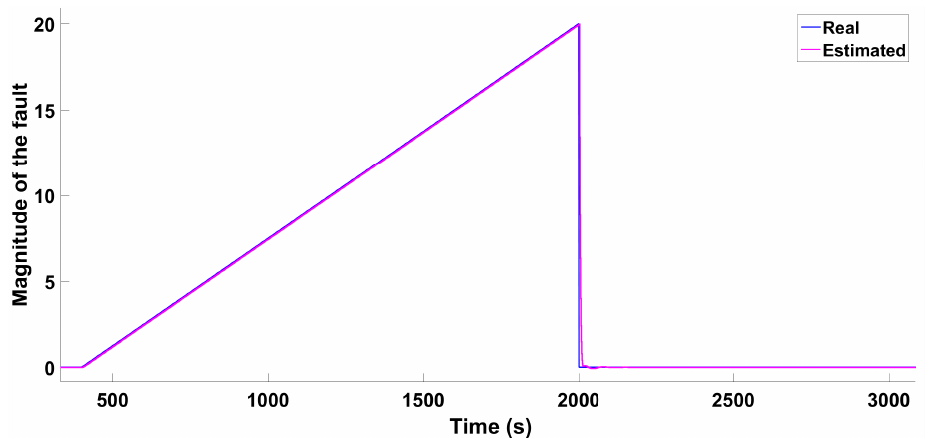
Figure 11. Scenario 1—Ramp-type fault: Real and estimated ramp-type fault on the reduced model